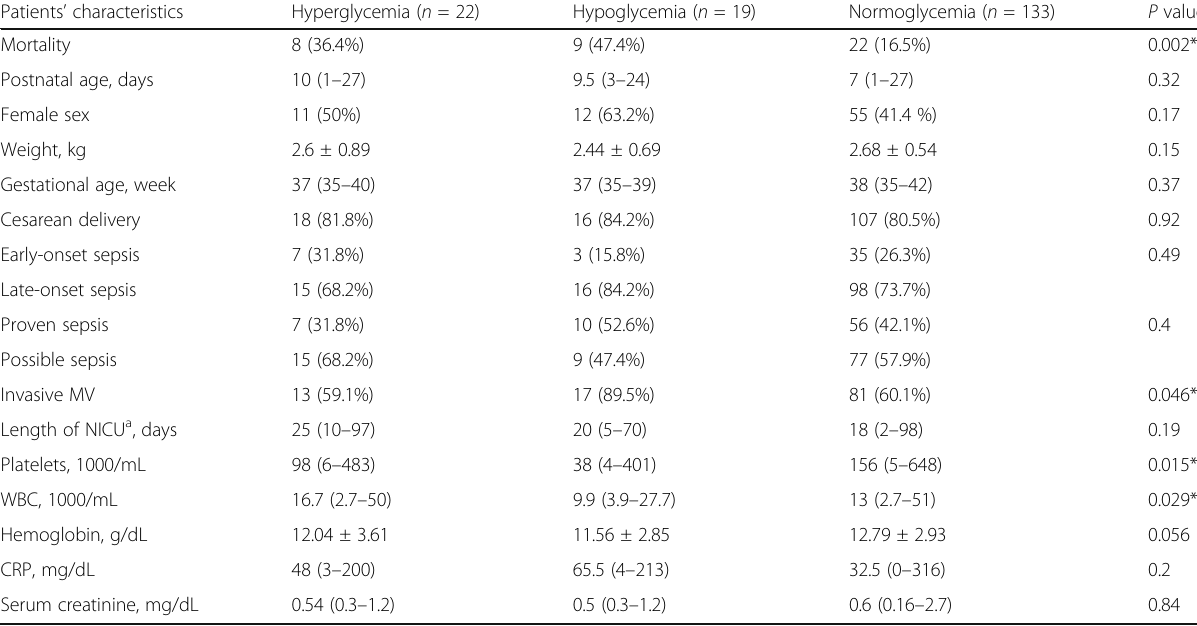
Table 2 Relation of the glycemic status to mortality and other patient characteristics Patients ’ characteristics